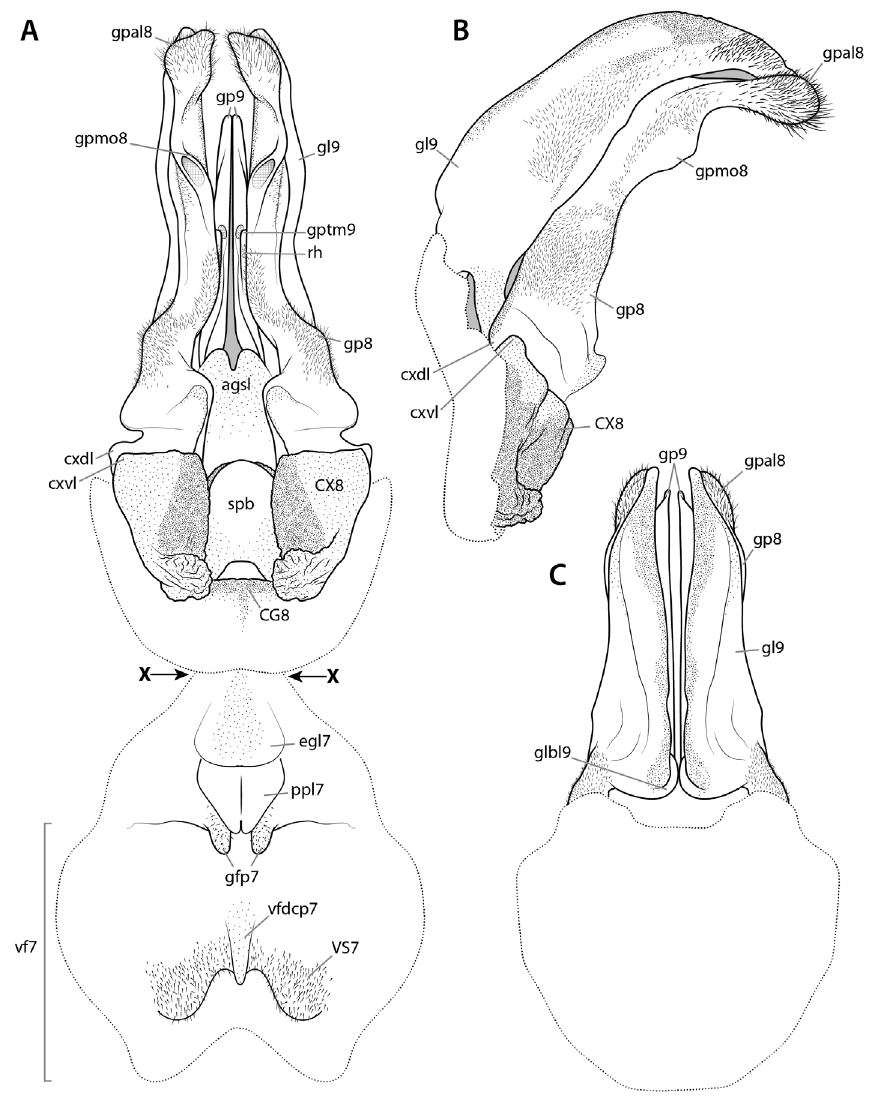
Figure 16. Annotated illustrations of intact female genitalia Tenodera sinensis for taxonomic use. A seg- ments are opened up 180° along the axis marked X, the upper half of the illustration shows the ventral side of segments VIII and IX in dorsal view, the lower half of the illustration shows the dorsal wall of the ventral fold vf7 and genital fold in ventral view B segments VIII and IX in lateral view C dorsal side of segments VIII and IX in dorsal view. Dotted lines indicate regions of membrane, connective tissues, and musculature. Abbreviations: agsl = accessory gland supporting lobe; CG8 = caudogyne; CX8 = coxa 8; cxdl = dorsolateral coxal lobelet; cxvl = ventrolateral coxal lobelet; egl7 = epigynal lobe; gfp7 = process of genital fold; gl9 = gonoplac 9; glbl9 = gonoplac basal lobe 9; gp8 = gonapophysis 8; gp9 = gonapophysis 9; gpal8 = apical lobe of gonapophysis 8; gpmo8 = medial outgrowth of gonapophysis 8; gptm9 = medial tine of gonapophysis 9; ppl7 = papilla lobe; rh = rhachis; sbp = spermathecal bulge; vf7 = ventral segmen- tal fold 7; vfdcp7 = process of dorsal carina of ventral fold 7; VS7 = vestibular sclerite